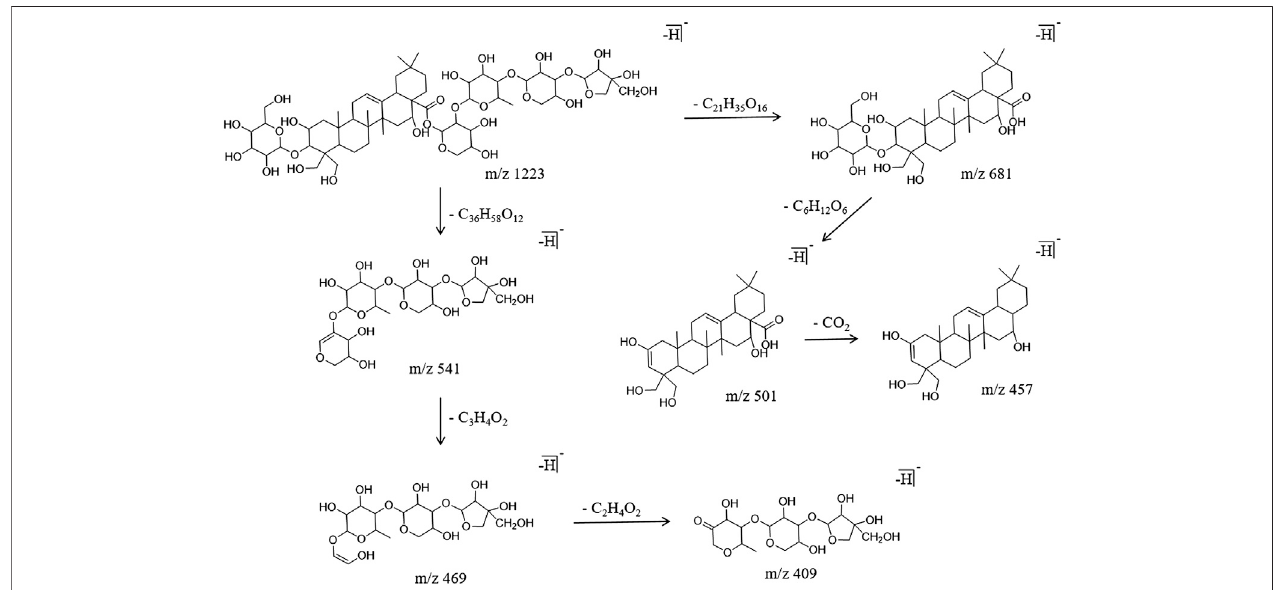
FIGURE 3 | Cracking pathway of triterpenoid